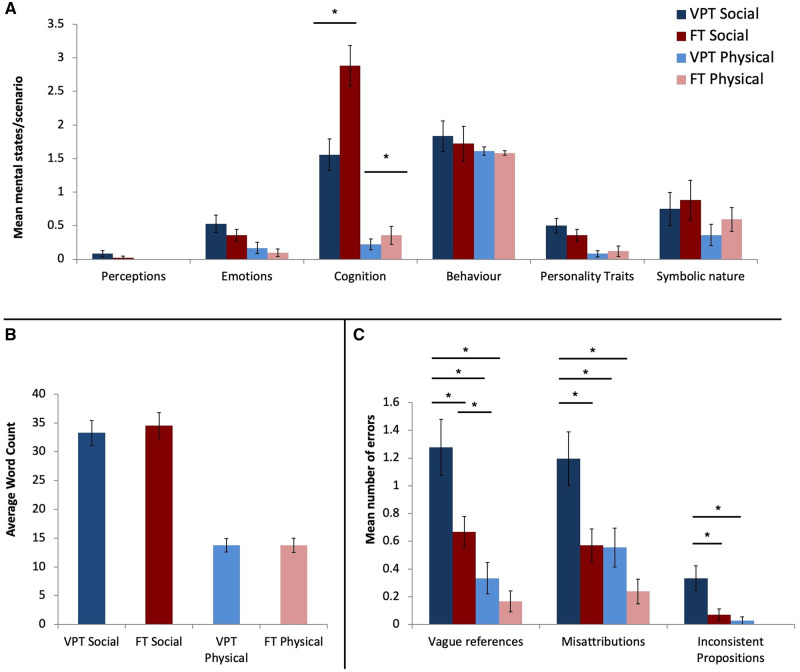
(A) The mean number of attributions in VPT and FT born children across scenarios, showing social interactions compared to random physical motion. FT children attributed more cognitive states (thoughts, wants and needs) compared to VPT children on the videos showing social interaction. Error bars represent standard error (SE). (B) Average word count in social and physical motion in each of the groups (±SE). (C) More errors were made by VPT than FT children in descriptions of scenarios involving social interactions and random physical movement (±SE).